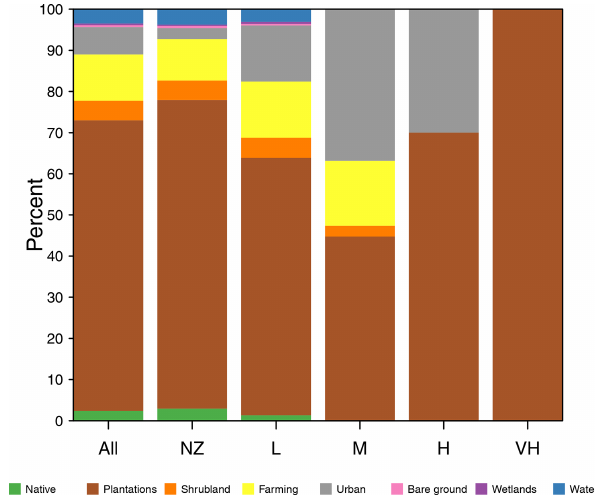
Figure 3. Land use (%) classified for the CMA according to the fol- lowing wildfire categories: near zero (NZ), low (L), moderate (M), high (H), very high (VH), and all. All represents the distribution of the land cover along the whole study